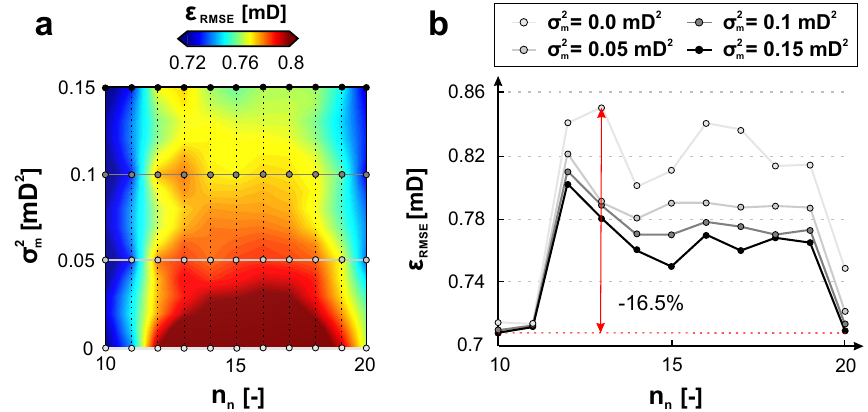
Figure 8. Results of the linear integer programming optimization using the marked sampling points. The interpolation error (cid:101) RMSE is minimized using the inequality constraints given in Equation (22). ( a ) RMSE response surface with regard to the incorporated measurement error variance σ 2 m and the maximum number of neighbors n n using a leave-one-out cross-validation. ( b ) Cross sections through the response surface of ( a